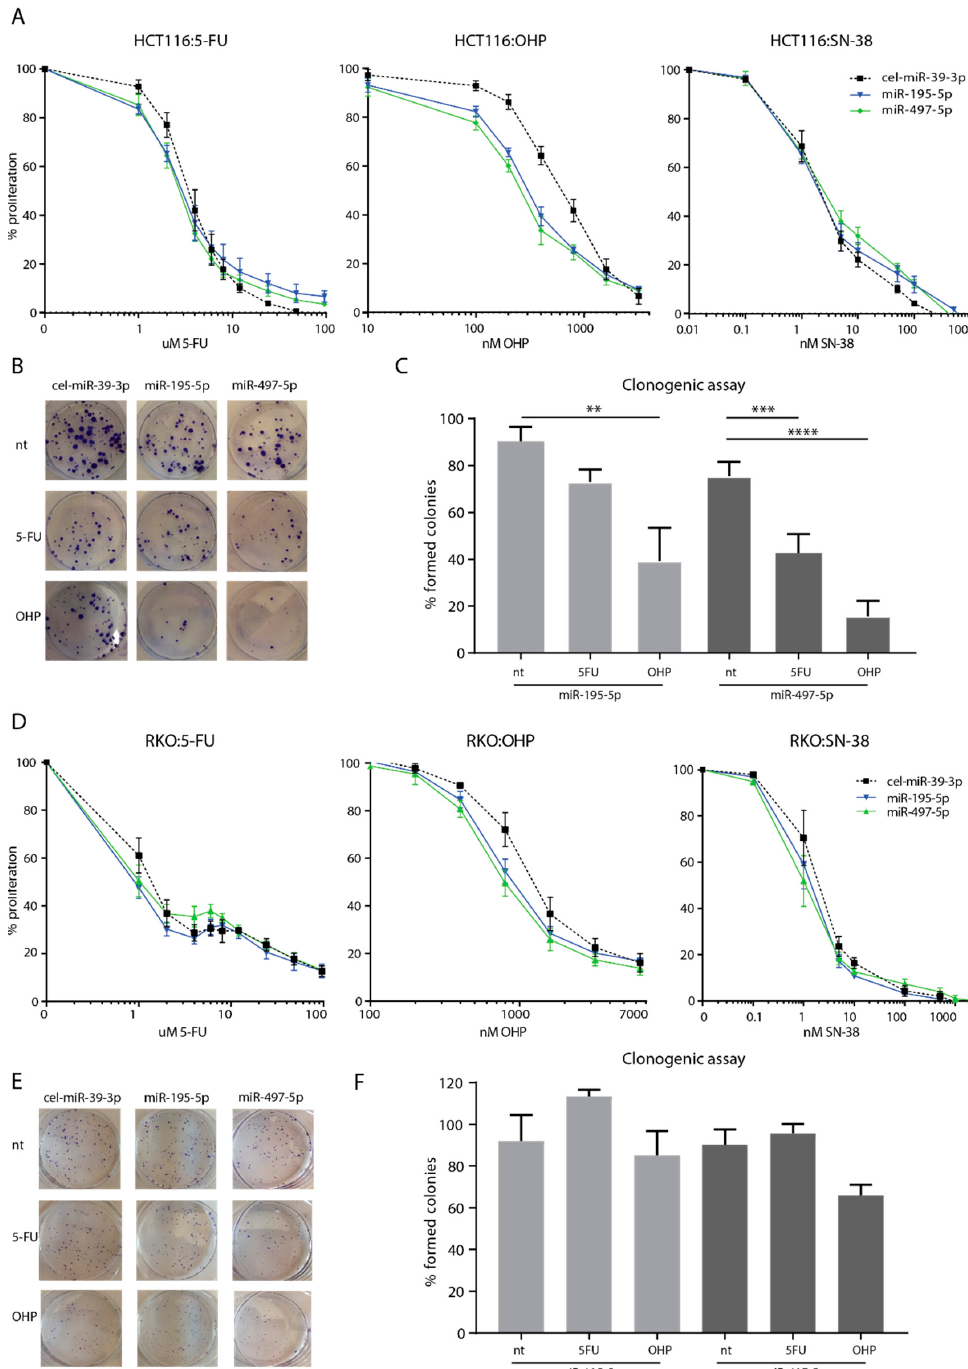
Figure 2. HCT116 and RKO cells after transfection with miR-195-5p or miR-497-5p mimic. MTT sensitivity assays for HCT116 cells ( A ) and RKO cells ( D ) were performed in triplicate in three independent experiments and are presented as average % proliferation compared to the proliferation of a non-treated control triplicate ± the standard error of the mean (SEM). Presentation of a single clonogenic assay experiment of HCT116 ( B ) and RKO ( E ). Bar graphs of the percentage of formed colonies compared to the negative control transfection (cel-miR-39-3p) of HCT116 cells ( C ) and RKO cells ( F ) presented as averages of duplicate colony counts from three independent experiments ± SEM. 5-FU; 5-fluorouracil, OHP; oxaliplatin, SN-38; irinotecan, nt; no treatment, ** p < 0.005, *** p < 0.001, **** p < 0.0001.